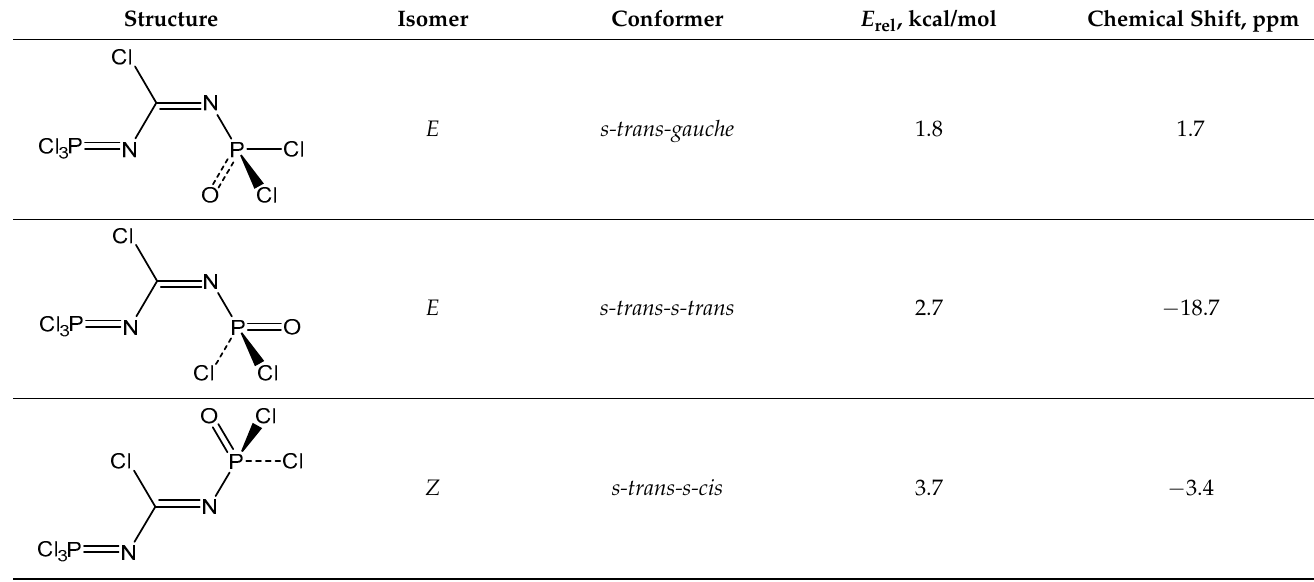
Table 14. Theoretical values of 31 P NMR chemical shifts and relative energies of conformers 39.